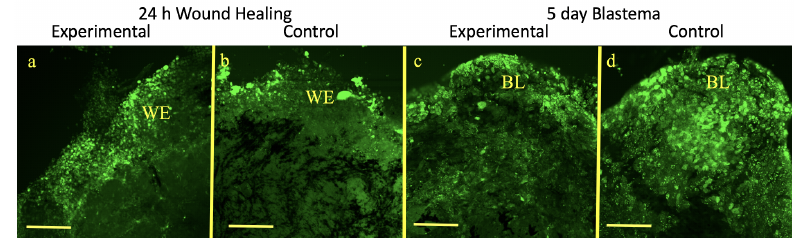
Figure 4. Ca 2 + fluorescence staining: At 24 h post amputation, wound epithelium (WE) of experimental tadpoles show higher intensity of Ca 2 + fluorescence (green) (Figure 4a) compared to control (Figure 4b). However, in day 5 blastema (BL) of experimental tadpoles, fluorescent staining was lower in Figure 4c compared to control Figure 4d; scale bar